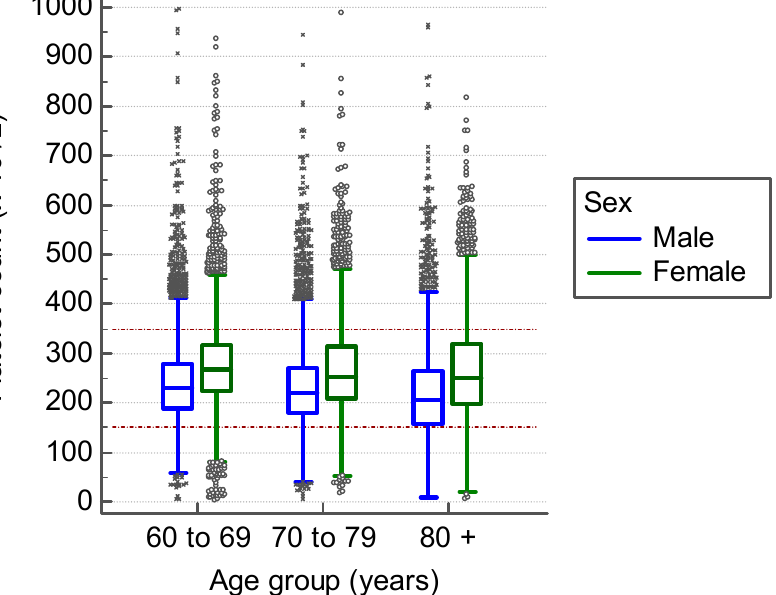
Figure 3. Platelet counts measured in Liechtenstein from 1 January 2013 to 31 December 2019, stratified by age and sex. Dotted lines represent conventionally used sex- and age-independent reference interval (150–350 × 10 9 /L) [21].